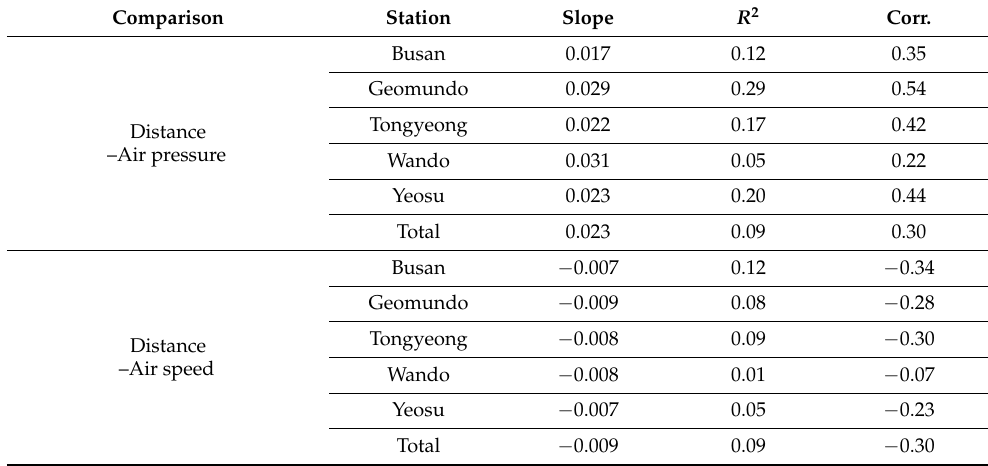
Table 3. Correlations between variables describing storm surges for five tidal stations (Busan, Geomundo, Tongyeong, Wando, Yeosu). Data on typhoons that affected the Korean Peninsula between 2010 and 2019 were